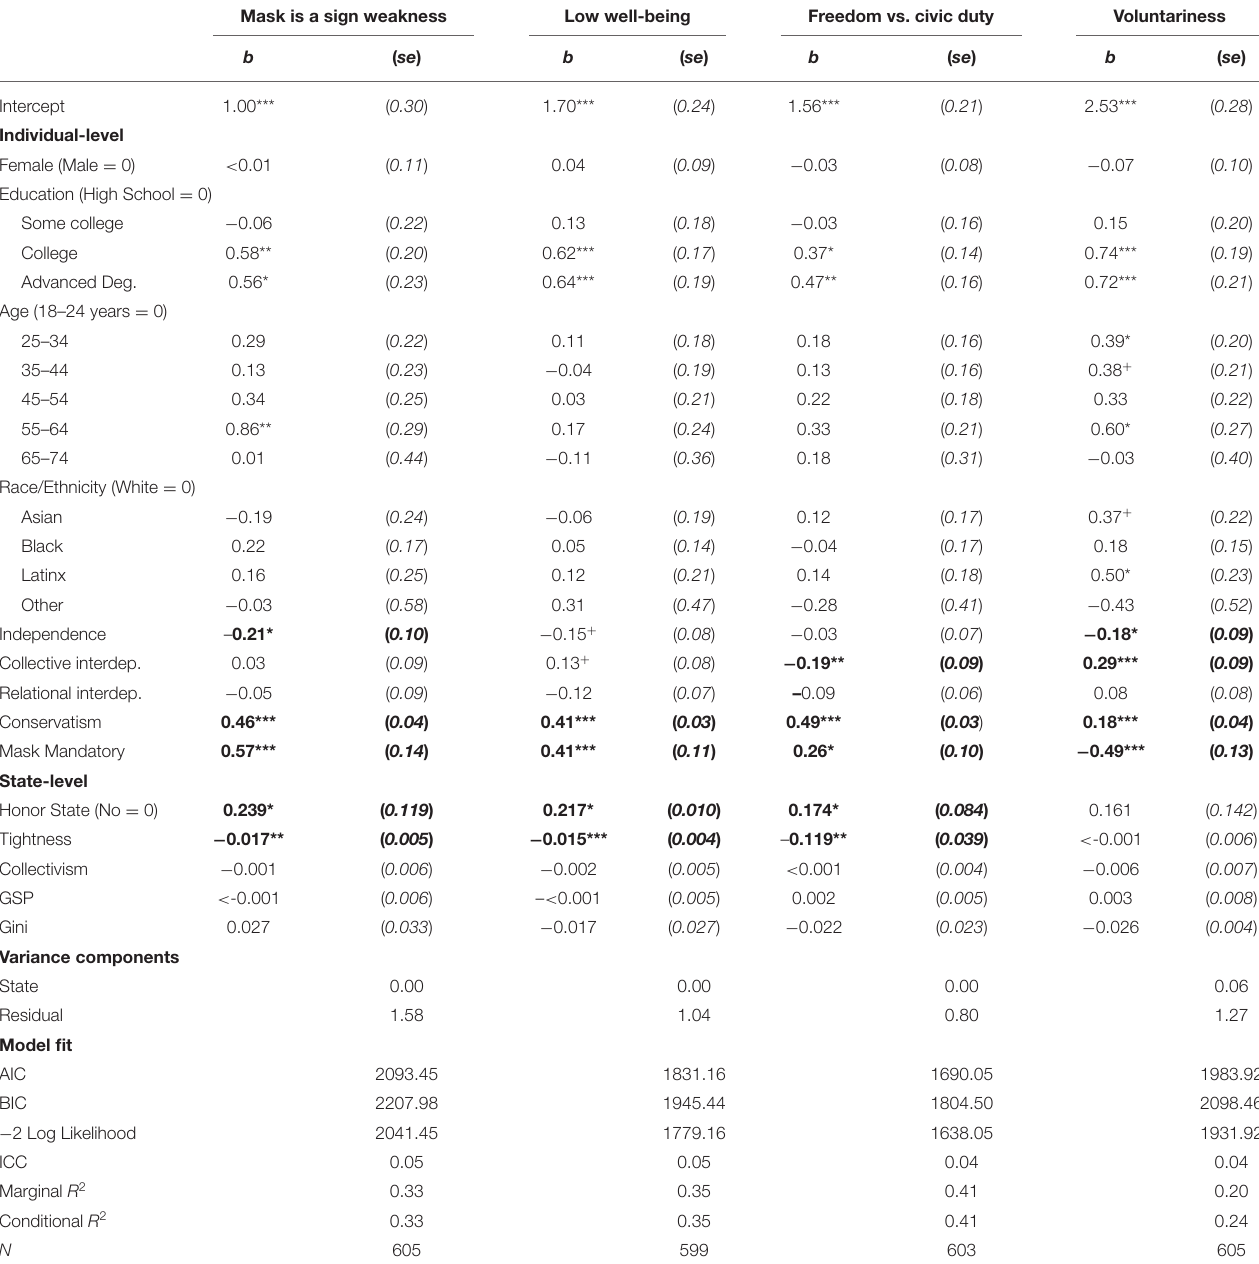
TABLE 6 | Result of multilevel analyses: weakness, well-being, freedom, and voluntariness. Mask is a sign weakness Low well-being Freedom vs. civic duty